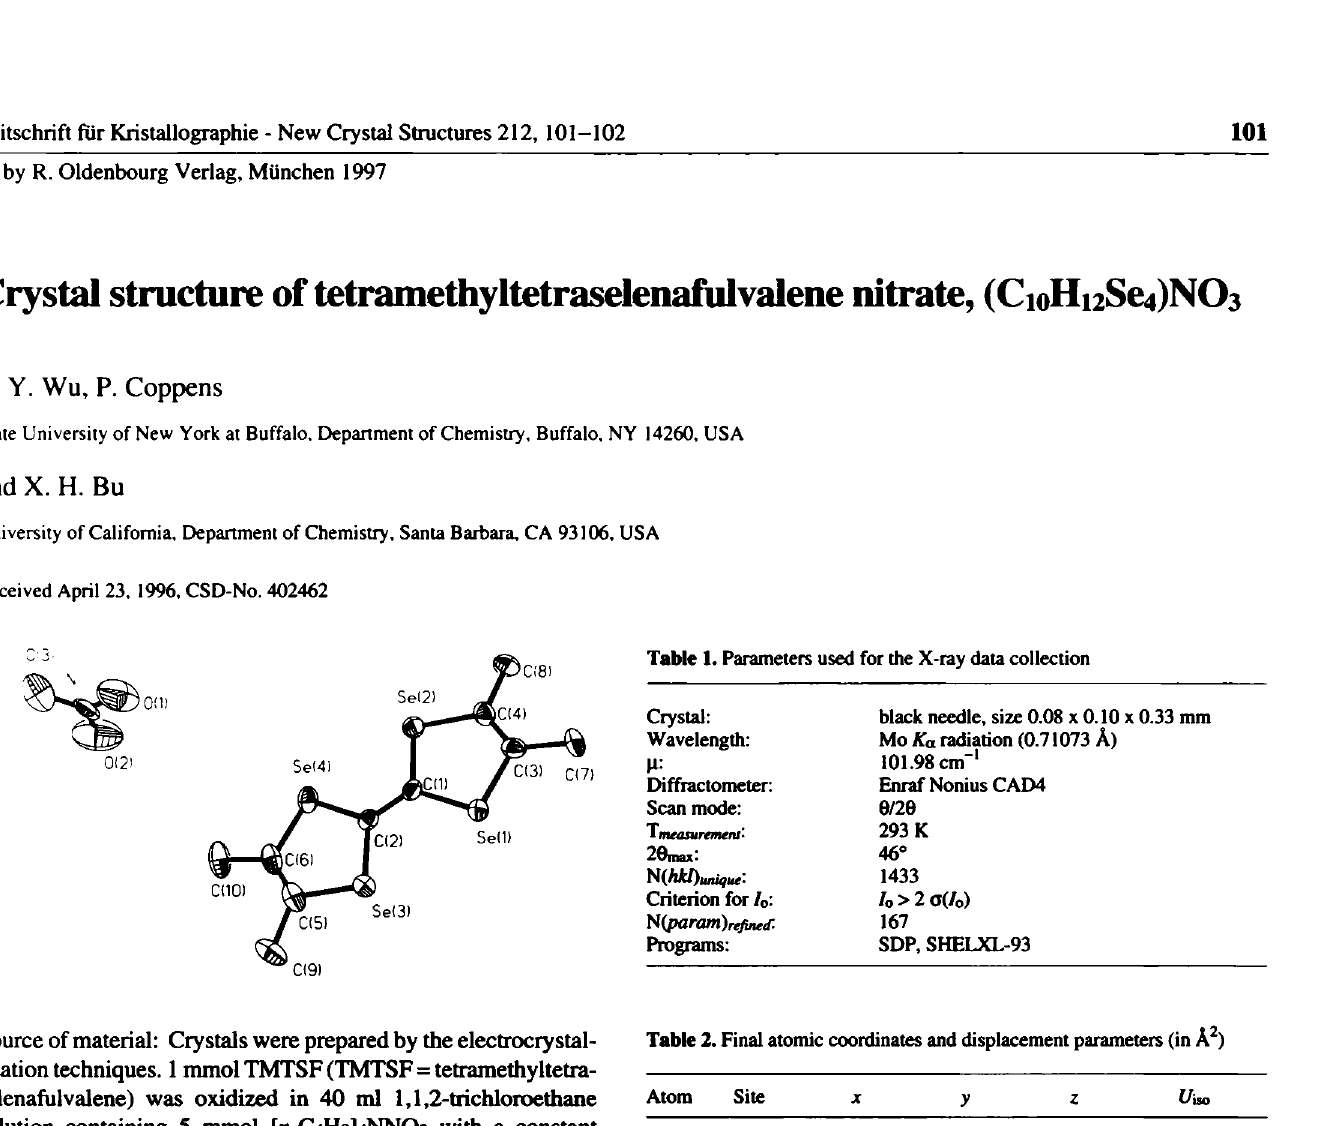
Table 2. Final atomic coordinates and displacement parameters (in À 2